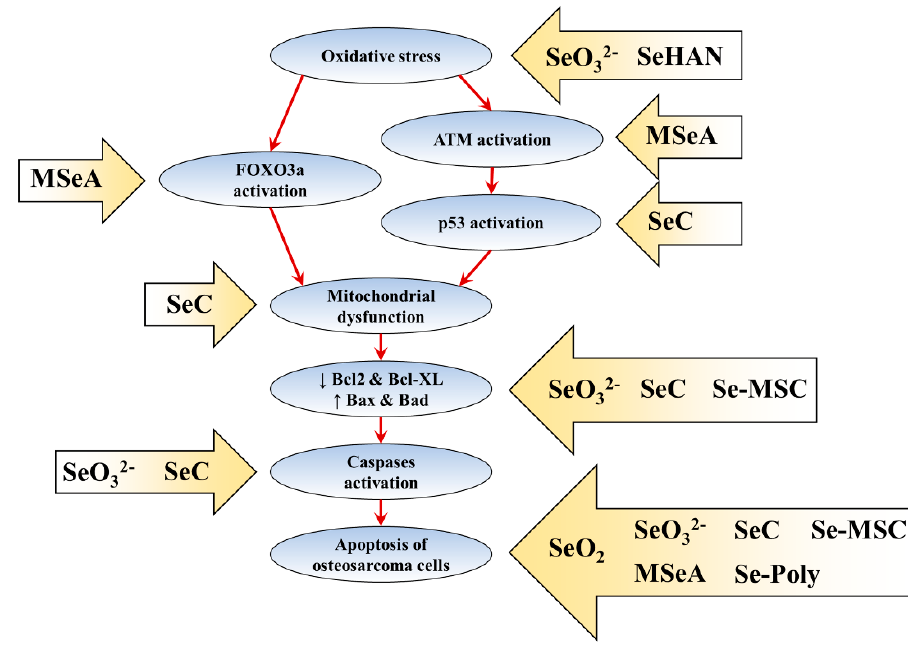
Figure 1. The molecular mechanisms of selenium-induced osteosarcoma cell death. The arrow boxes with selenium species showed the reported effects of selenium species on the apoptosis pathway. The red arrows indicate the sequent of events in apoptosis pathway